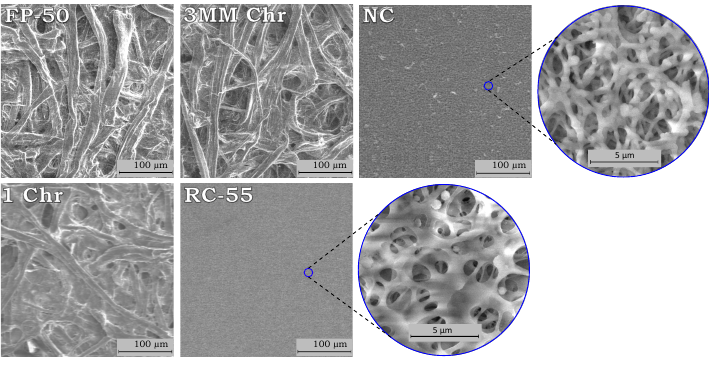
Figure 4. Scanning electron microscope (SEM) images of the fiber structure for the different paper